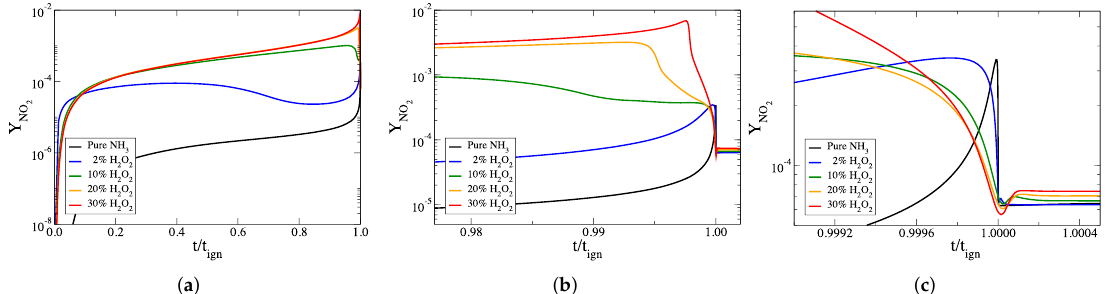
Figure 5. The temporal evolution of the mass fraction of NO 2 against scaled time, for all cases considered: ( a ) the full explosive stage, ( b ) the final part of the explosive stage and ( c ) at ignition. The mass fraction of NO 2 in the final products can be seen most clearly in panel ( c ).